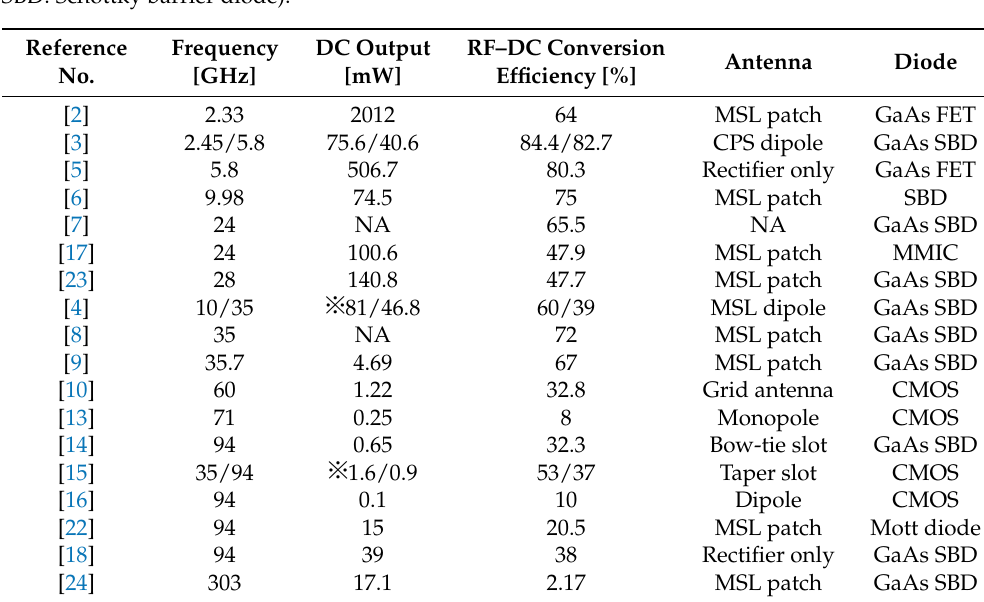
Table 1. Characteristics of rectenna in earlier studies (MSL: Microstrip line, CPS: Coplanar slot line, SBD: Schottky barrier